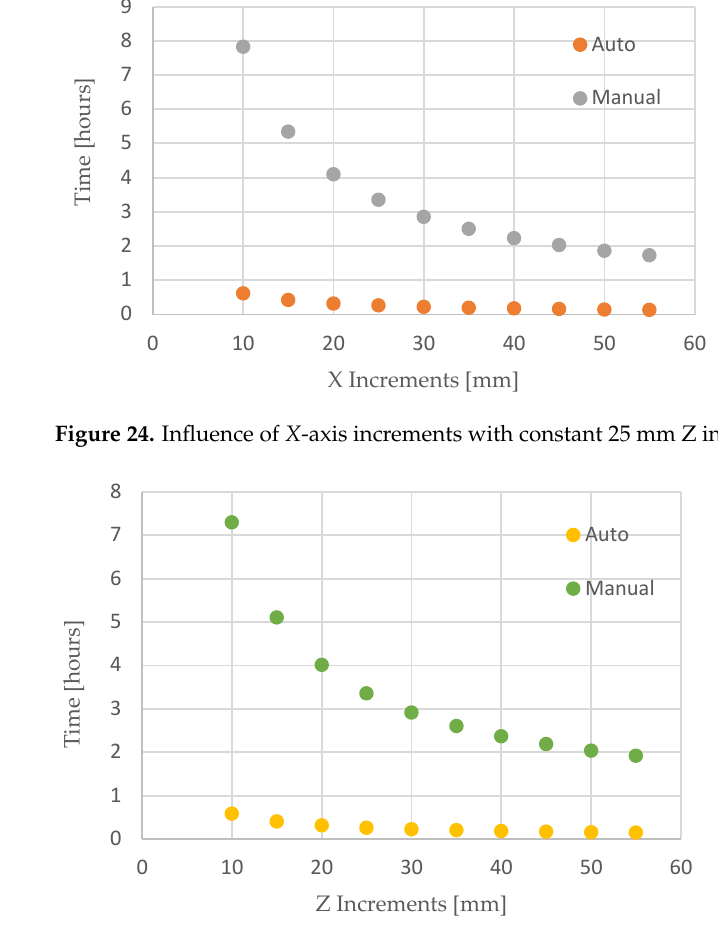
Table 8. Manufacturer’s axis accuracy specs.